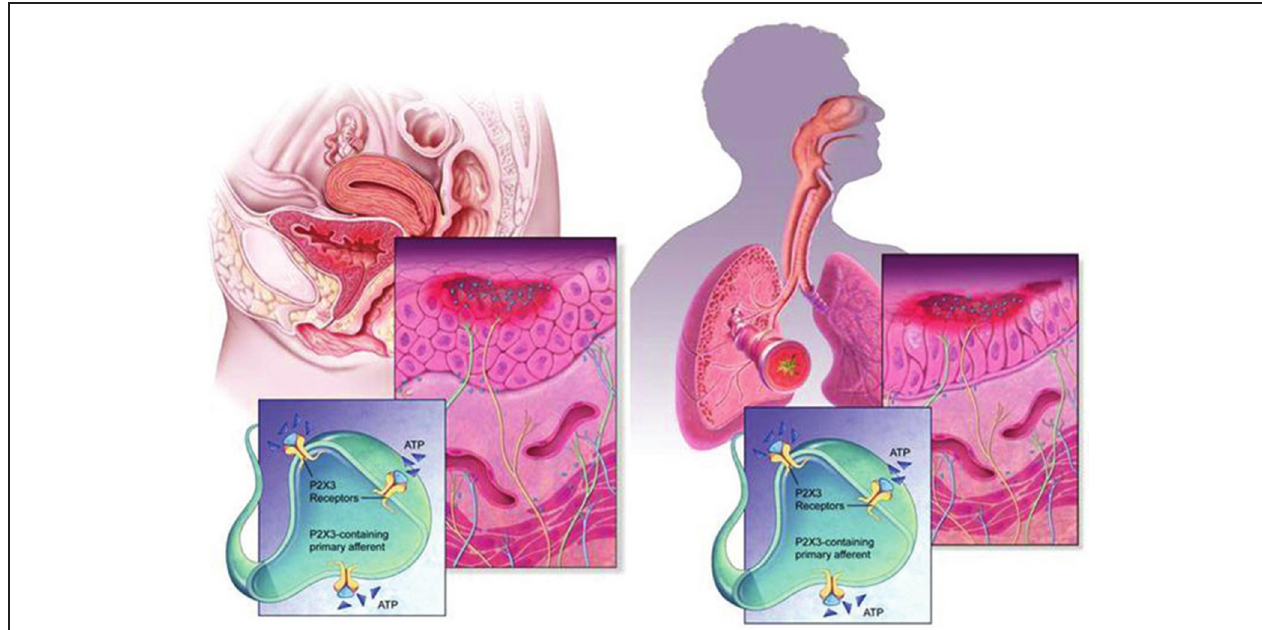
FIGURE 3 | Morphology and wiring of LUT and airways . The urinary tract and airways walls show a similar overall morphology, despite quite distinct structural differentiation in the epithelial layer. In both systems, ATP (shown as blue triangles) is present in large extracellular